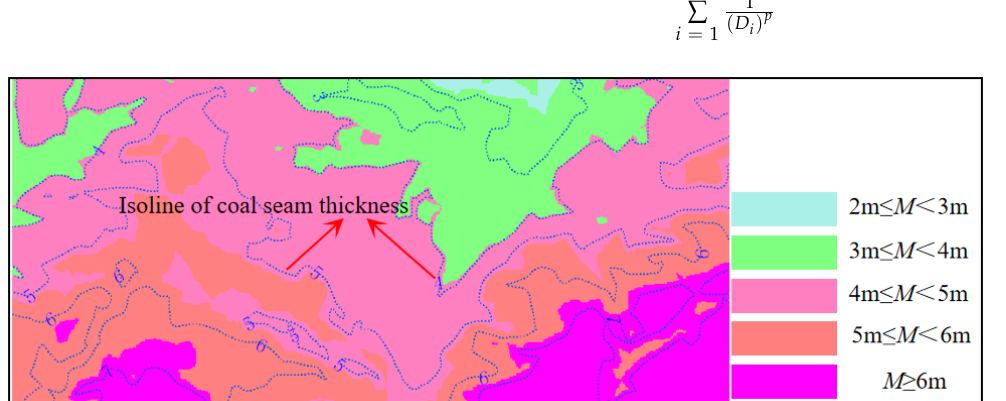
Figure 1. Coal seam thickness grid and isoline map of coal seam thickness.